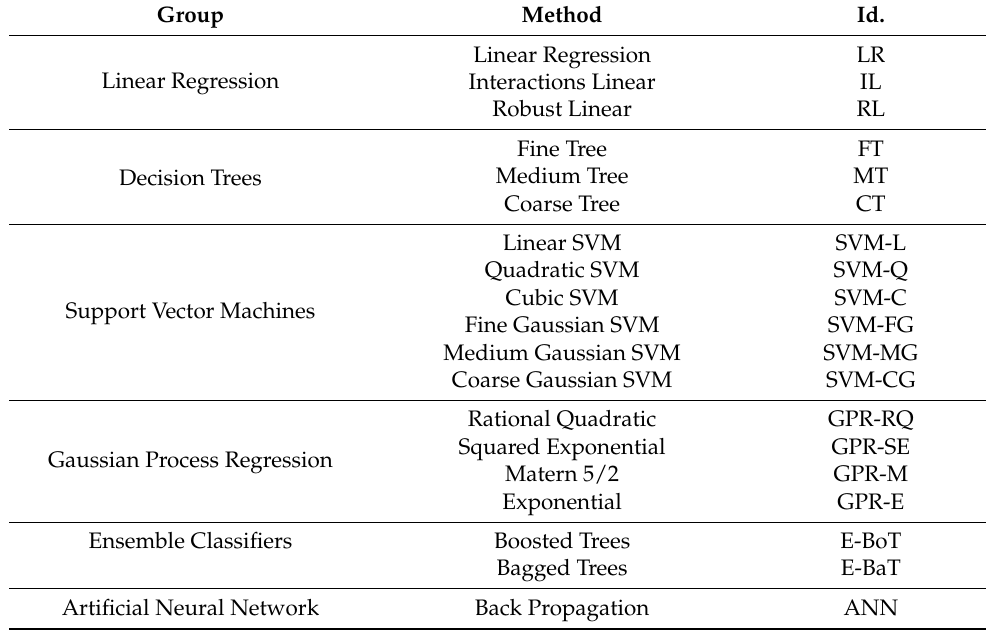
Table 4. Machine learning algorithms evaluated. Group Method